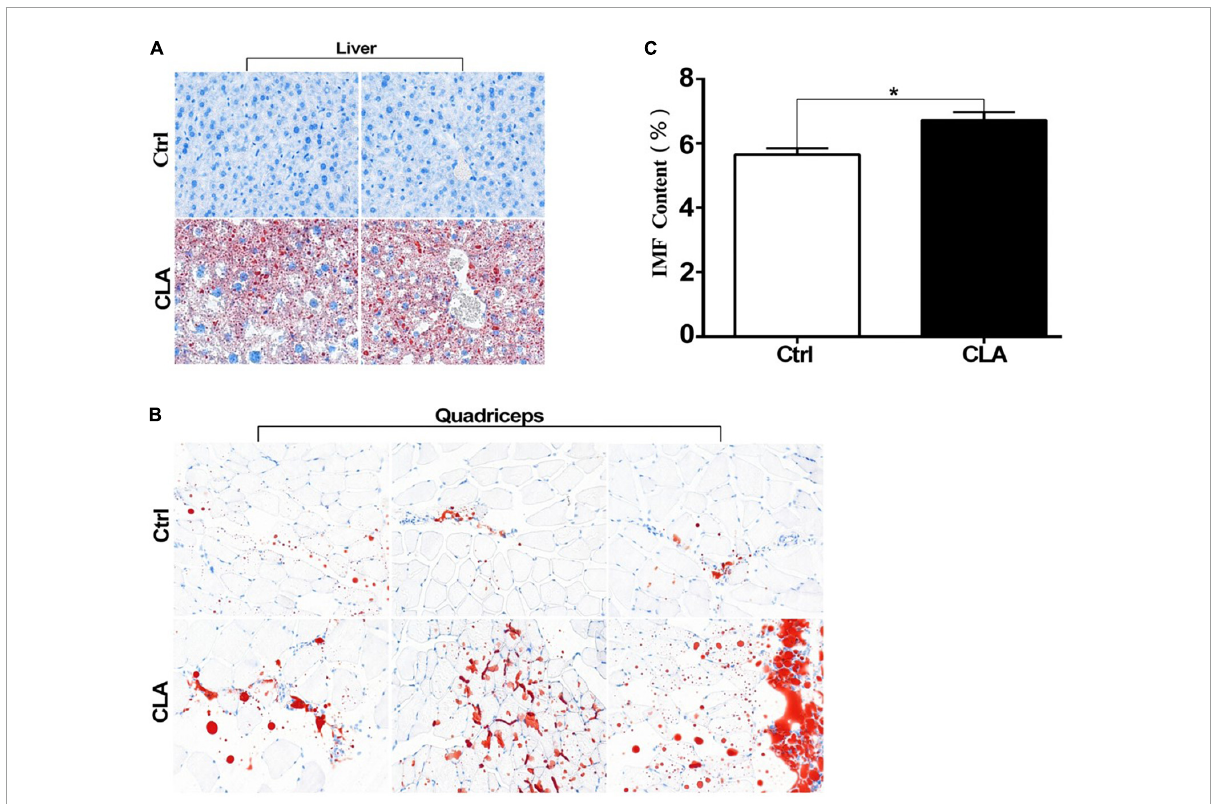
FIGURE3 Conjugated linoleic acid promoted fat deposition in liver and the quadriceps femoris of mice. (A,B) The liver tissues and quadriceps femoris muscles of mice were fixed with 4% formaldehyde. Frozen slides were made from these tissues and then stained with oil red O (magnification:200X). (C) The IMF content in the quadriceps femoris of mice was determined by the Soxhlet extraction method. Data in panel (C) were analyzed by t -test. * P <